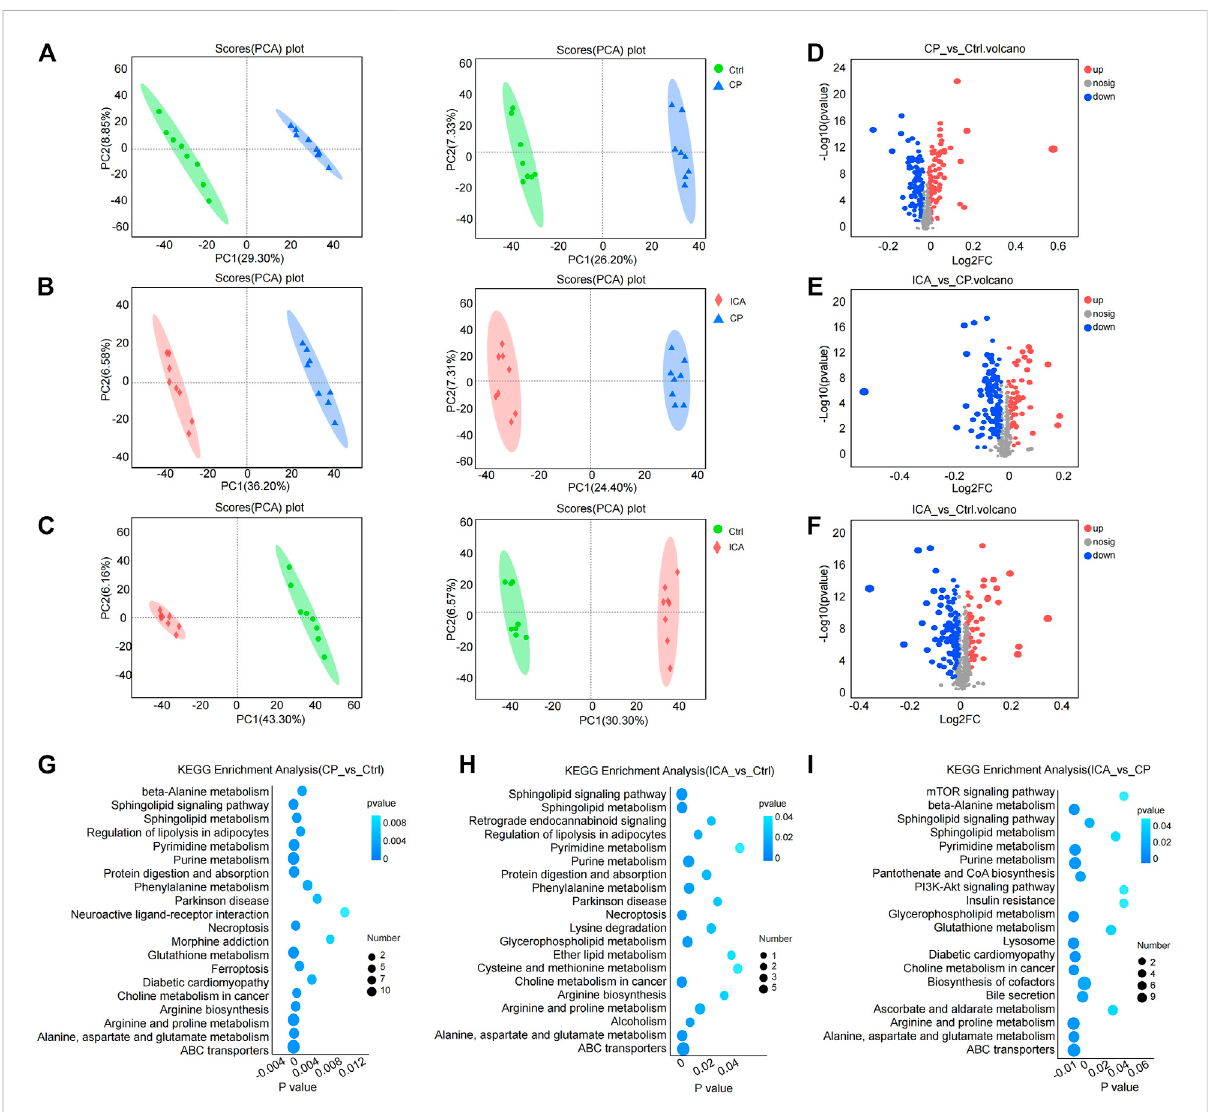
FIGURE 4 Metabolomics analyses revealed metabolic changes in ICA treatment of dysfunctional testis induced by CP. (A) PCA plots of “ Ctrl vs. CP ” in positive (left) and negative (right) ion scanning mode. (B) PCA plots of “ CP vs. ICA ” in positive (left) and negative (right) ion scanning mode. (C) PCA plotsof “ Ctrlvs.ICA ” inpositive(left)andnegative(right)ionscanningmode. (D) Volcanomapof “ Ctrl ” vs.CP ” . (E) Avolcanomapcomparing “ CP ” and “ ICA ” . (F) An overview of the volcano map of “ Ctrl ” versus “ ICA ” . (G) The enriched top 20 KEGG pathways of “ Ctrl vs. CP ” . (H) The enriched